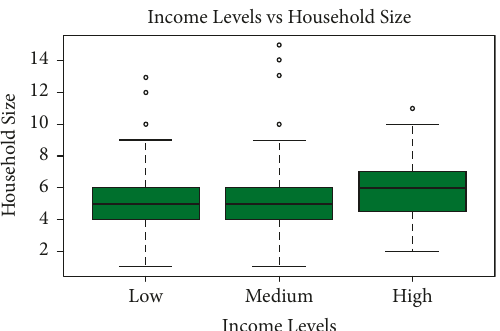
Figure 3: Box-plot of household size ( y -axis in number of persons per household) in the three income samples ( x standard deviations from the mean, and the dotted circles show all sample values which are outside this range.